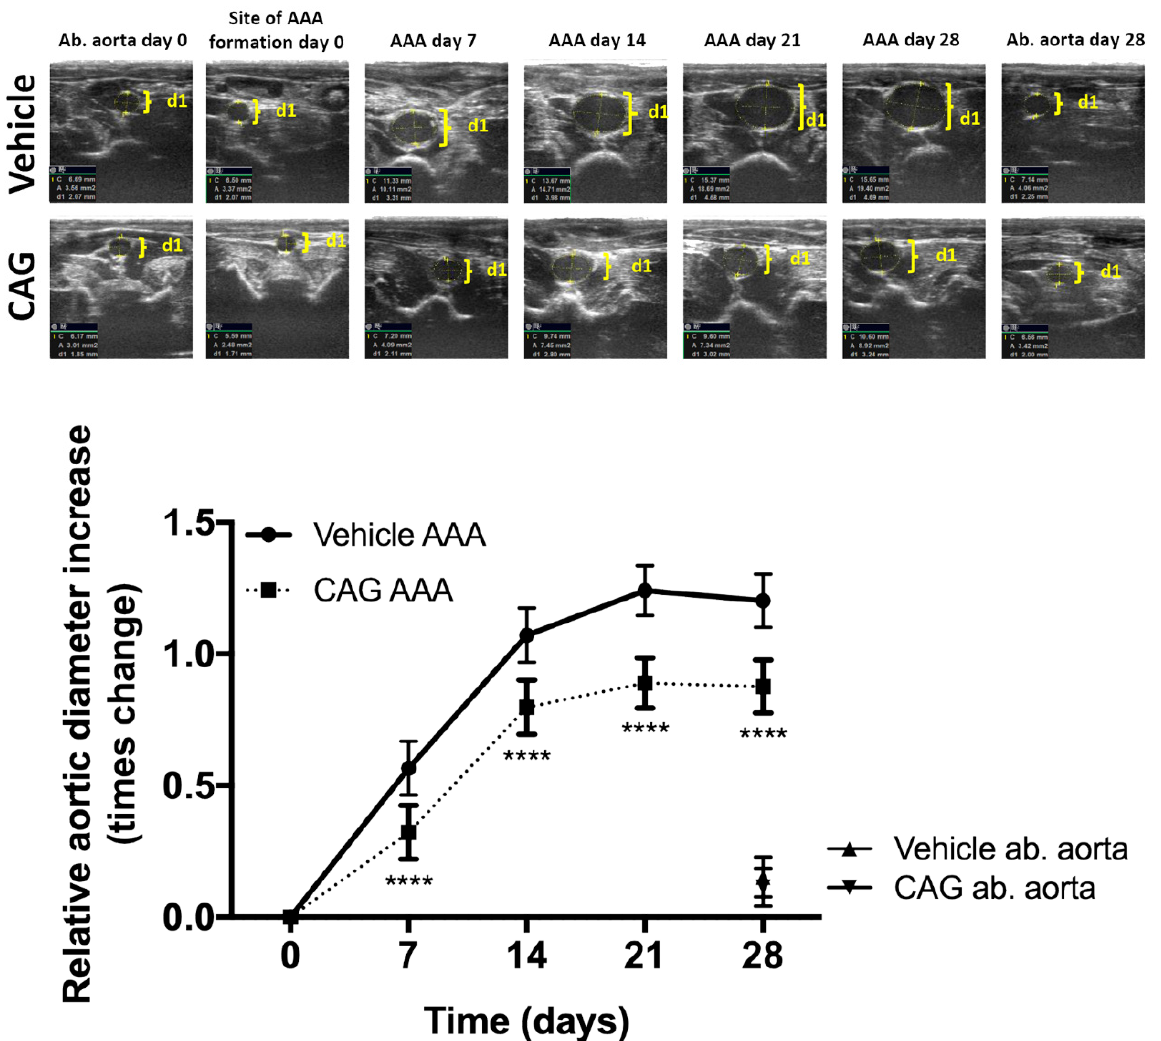
Figure 2. The effect of CAG on AAA growth. Upper panel shows representative ultrasound record- ings at baseline and post-surgery days 7, 14, 21, 28 for both vehicle and CAG treated rats. The abdominal aorta (Ab. Aorta) just distal from the left renal artery was used as a reference point for developmental aortic expansion in the experimental period (day 0 and post-surgery day